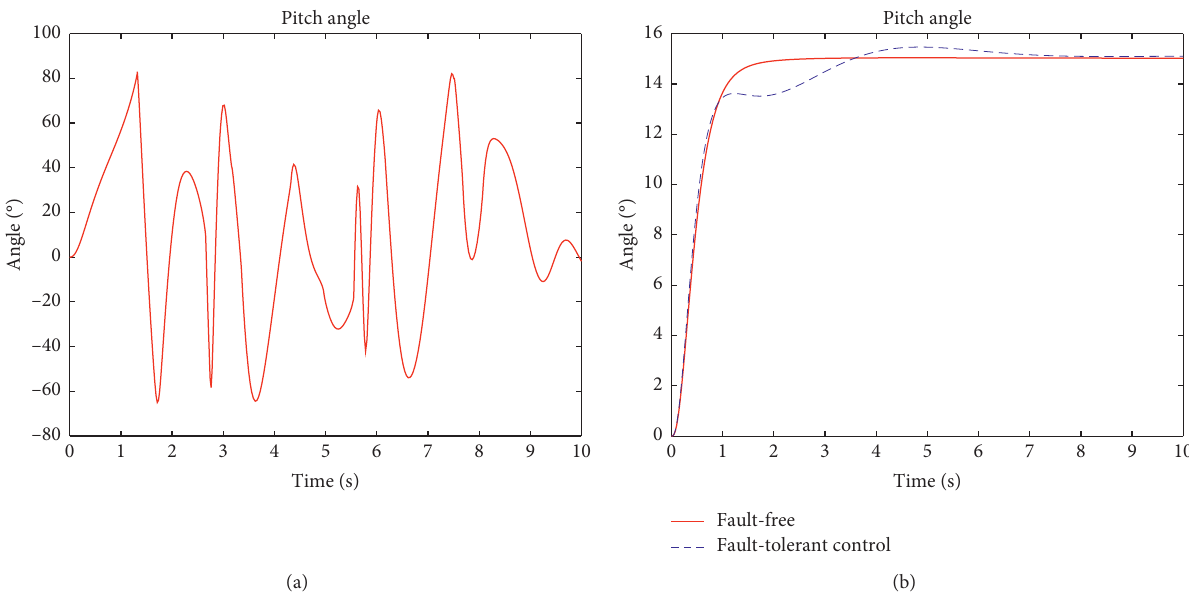
Figure 7: Comparison diagram of the pitch angle before and after fault-tolerant control. (a) Non-fault-tolerant control. (b) Fault-tolerant